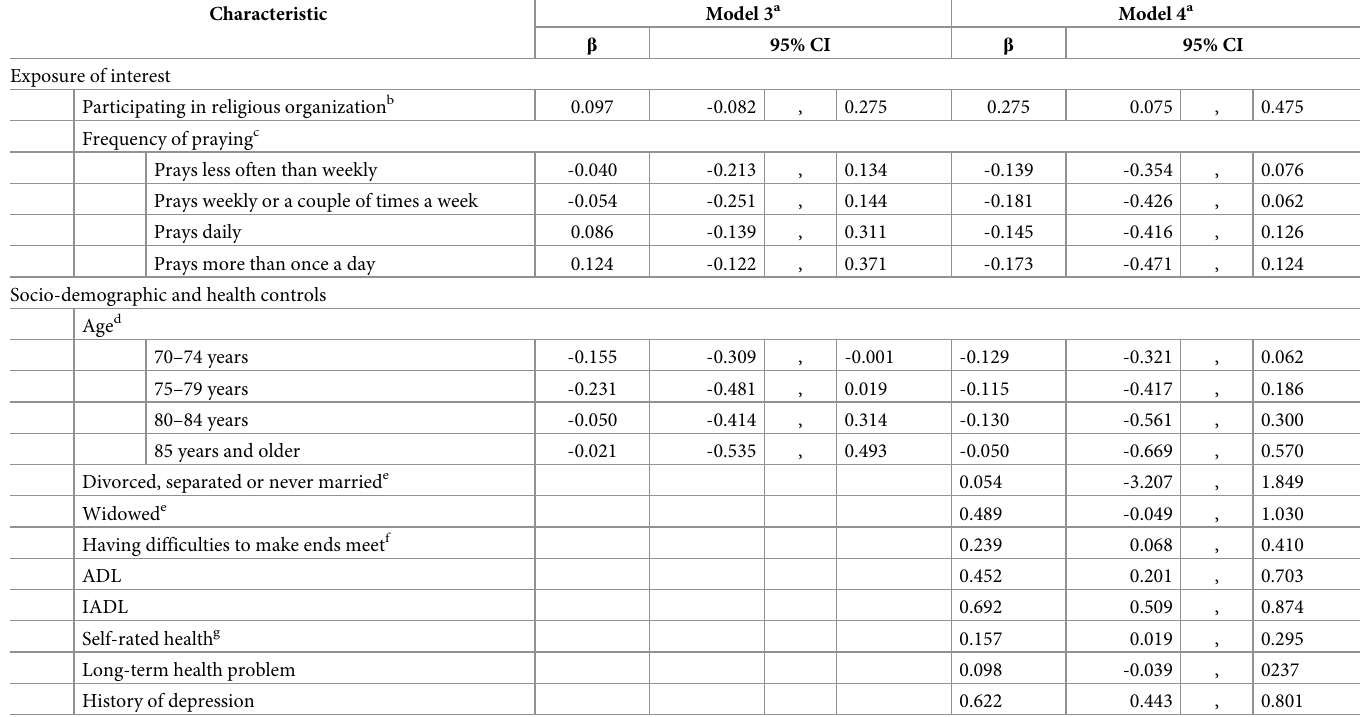
Table 4. Fixed-effects models, religiousness and depressive symptoms among respondents aged 65 years or older, survey of health, ageing and retirement, 2004– 2013.